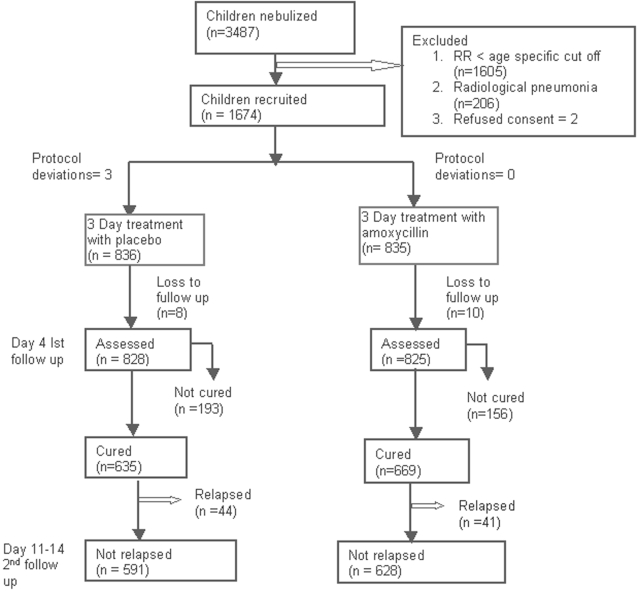
CONSORT Statement for the trial.